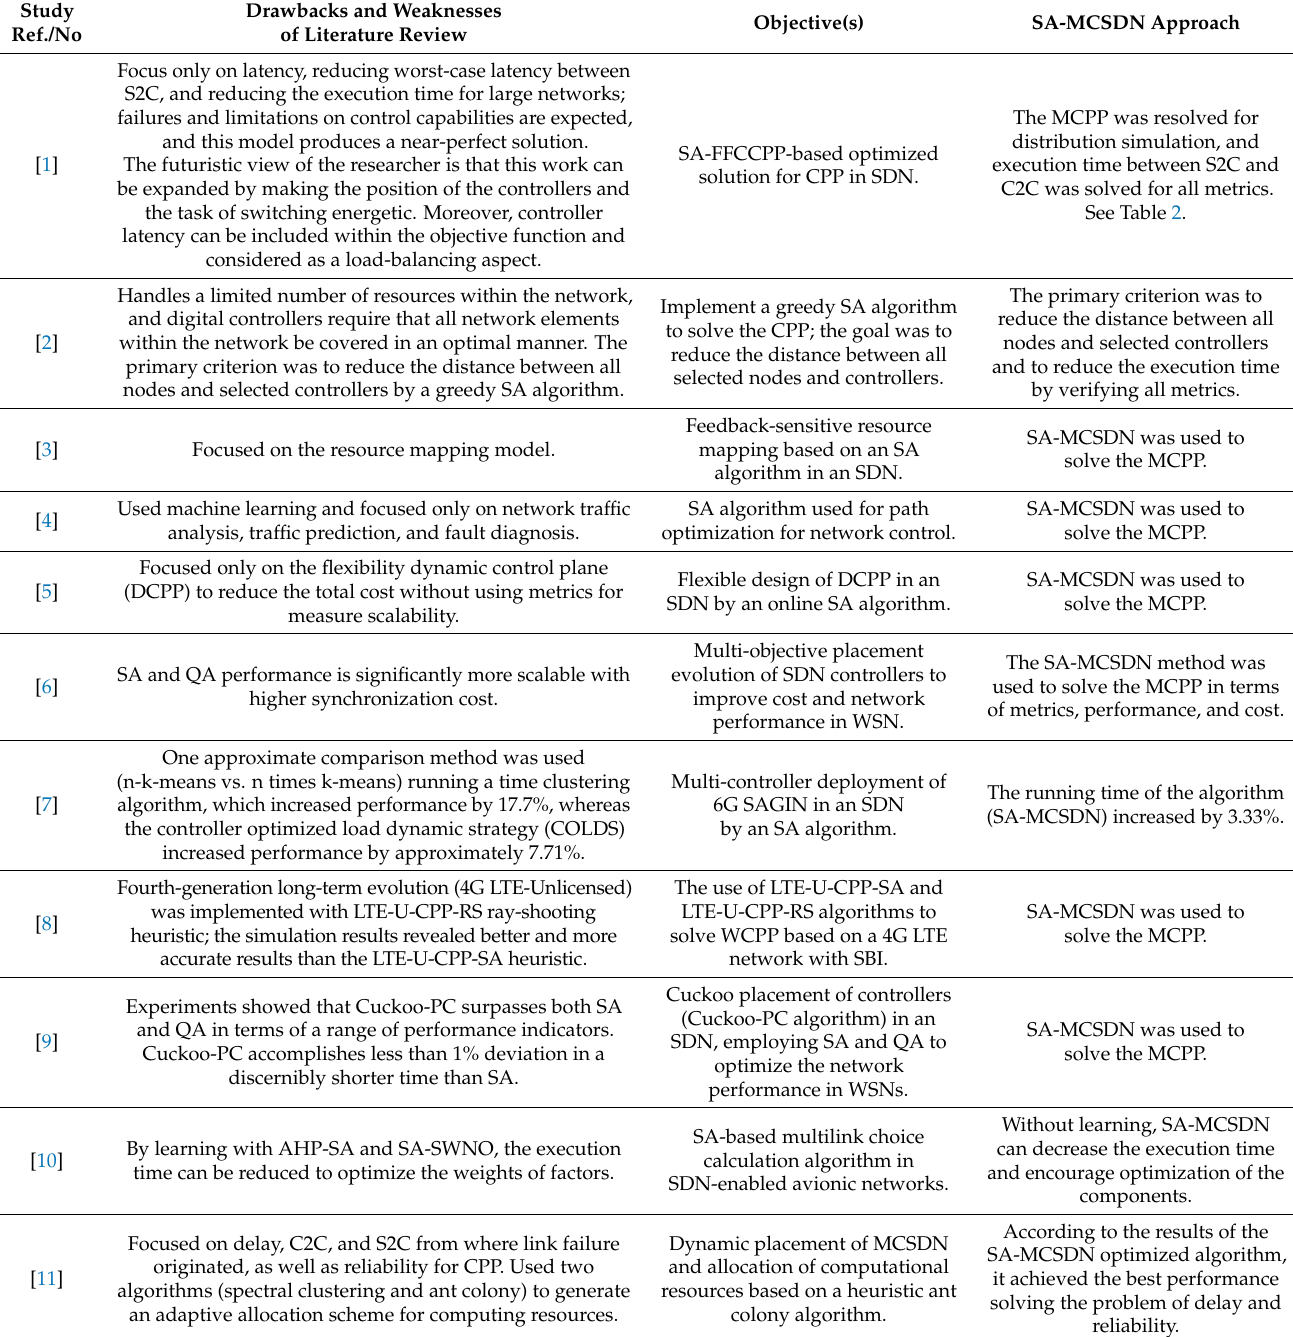
Table 1. Comparison of the proposed SA-MCSDN algorithm with previous